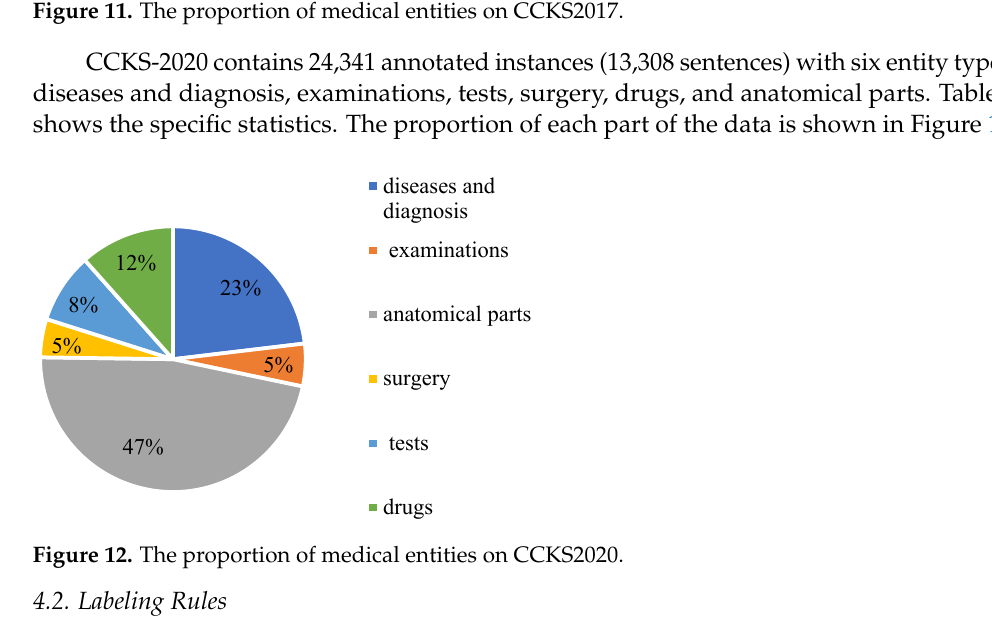
Figure 12. The proportion of medical entities on CCKS2020.